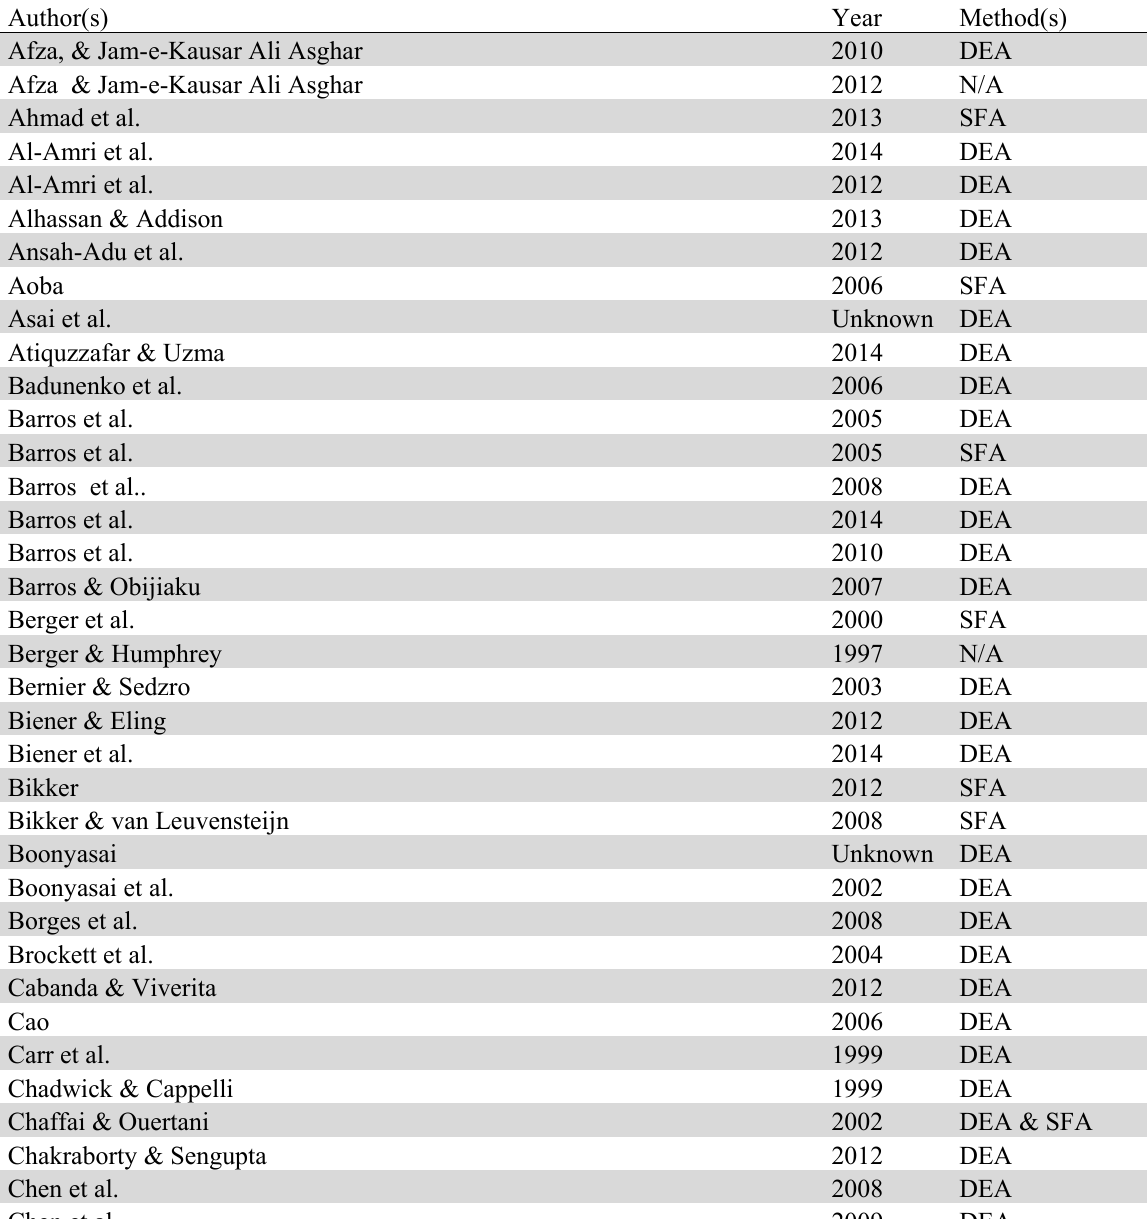
Life insurance efficiency studies in survey and method used to determine efficiency